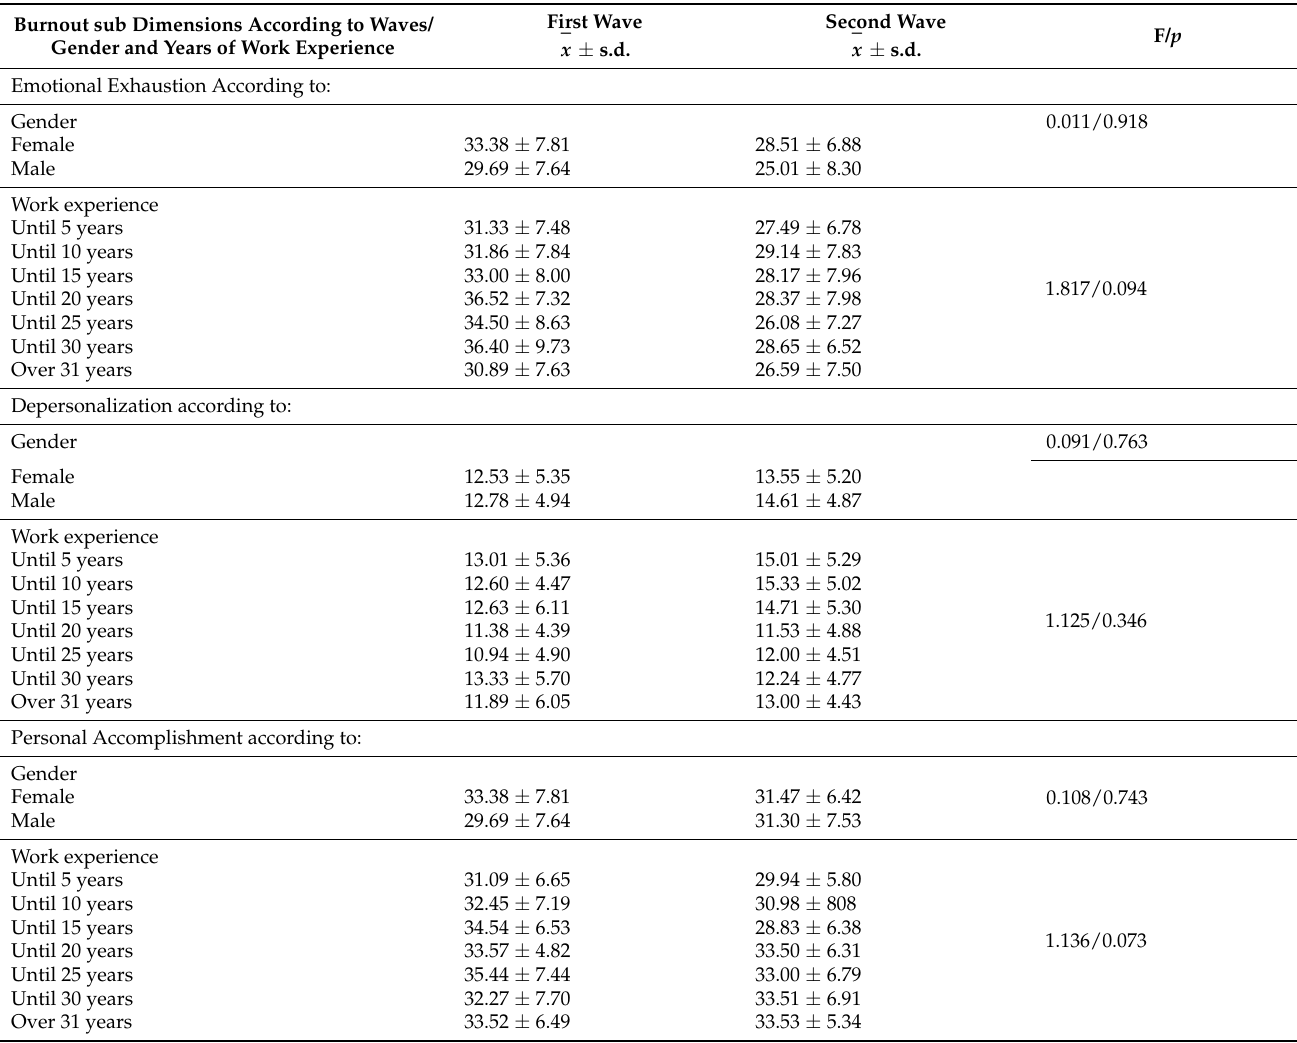
Table 3. Multivariate analysis between burnout sub dimensions (emotional exhaustion, depersonal- ization, personal accomplishment) according to gender and work experience during the first and the second waves of the COVID-19